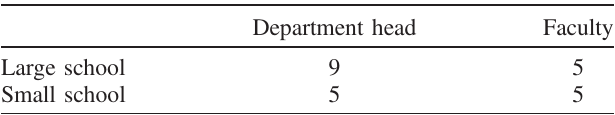
TABLE I. Distribution of study participants as department heads and faculty members at large and small